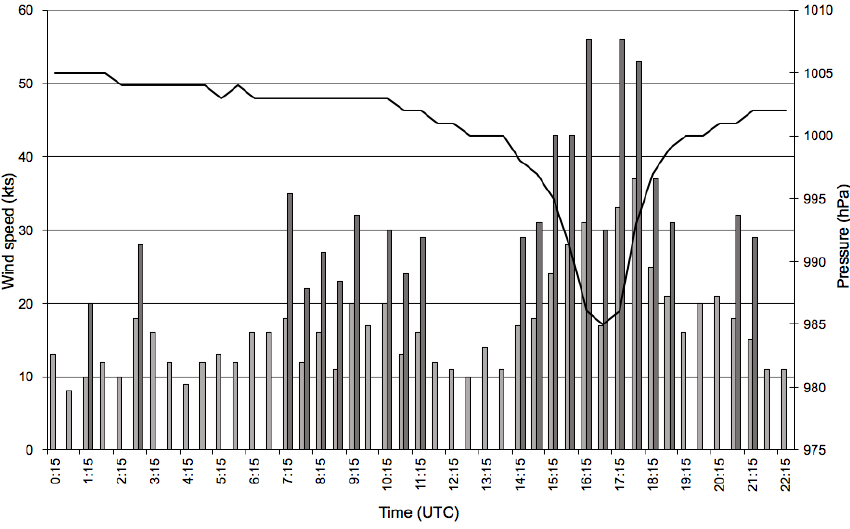
Figure 3. Surface pressure (hPa, solid line), sustained wind and gusts (ms − 1 , light and dark gray bars, respectively) from the METAR station in Malta. Indicated times (in UTC) are for 7 November